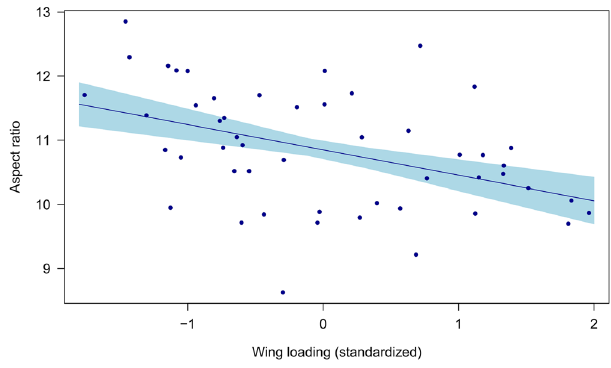
Fig. 3 The relationship between wing loading and aspect ratio in the Larinae. Species that are heavier relative to their wing area have a relatively broader wing chord. The shaded area depicts standard error. N = 50